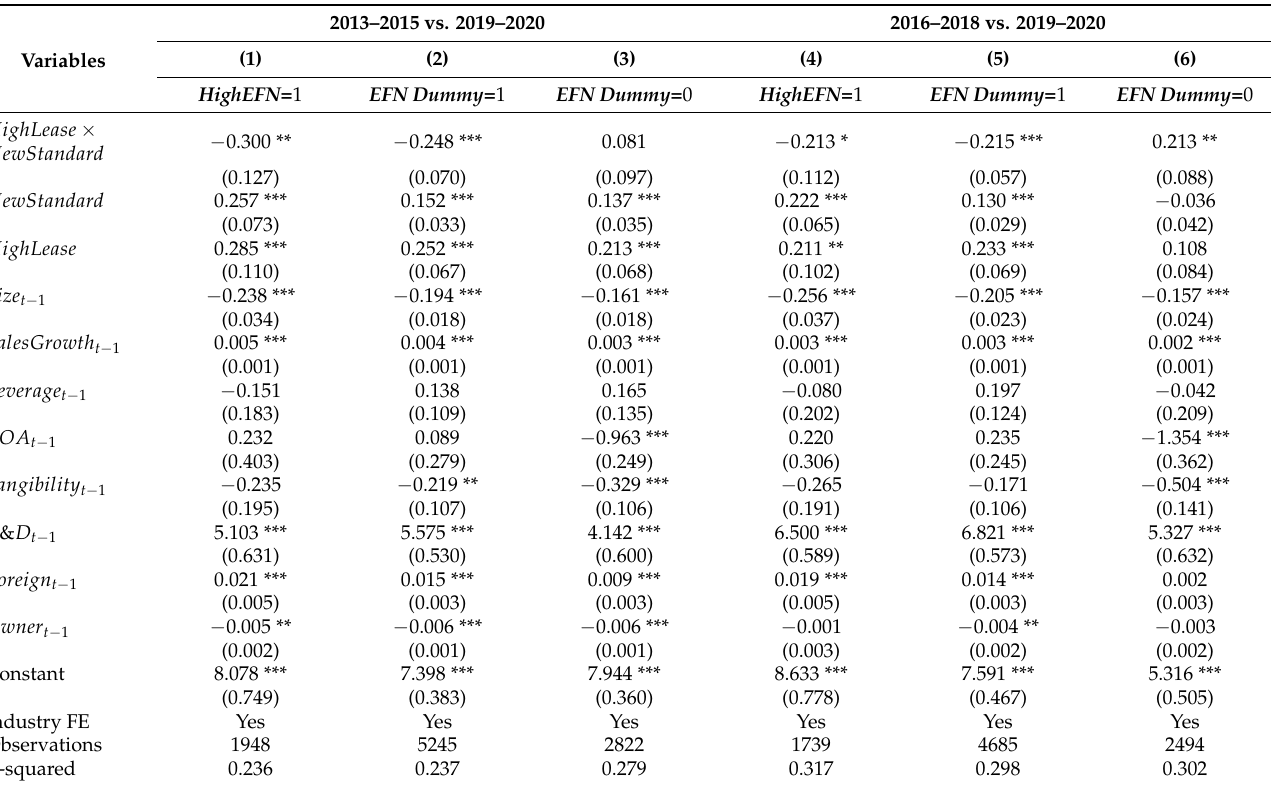
Table 6. External financing needs (EFN) and the effect of K-IFRS 1116 on firm value. This table documents the effect of K-IFRS 1116 on firm value for the subsamples categorized by the EFN. The dependent variable is Tobin (cid:48) s q . Standard errors are clustered at the firm level and are reported in parentheses. *, **, and *** denote statistical significance at the 10%, 5%, and 1% levels,